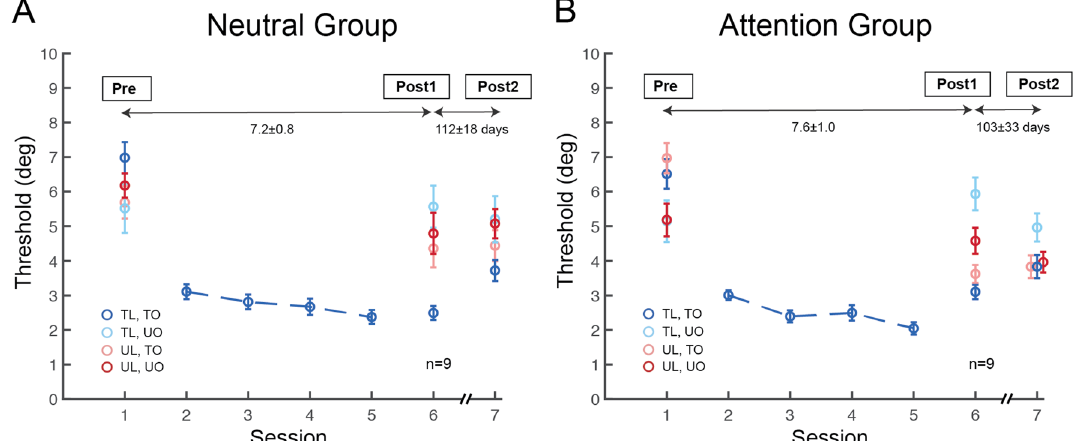
Figure 3. Spatial-transfer, but not feature-transfer, induced by feature-based attention in perceptual learning. ( A ) Session-by-session thresholds for orientation learning in the Neutral group. Performance improved for the trained feature at the trained location (dark blue circles), but not in the other three untrained conditions. The Neutral group exhibited both location- and feature- specificity in Post-test 1, as well as in Post-test 2. ( B ) Session-by-session thresholds for orientation learning in the Attention group. Similar to the Neutral group, observers retained improvement in the trained condition in both Post-test 1 and Post-test 2. (dark blue circles). Remarkably, training with FBA enabled complete learning transfer to the untrained location (light red circles), but not to the untrained orientation (light blue, dark red circles). Moreover, the improvement and location transfer induced by FBA persisted up to 3–4 months after training (dark blue, light red circles). Error bars represent ± 1 within-subject